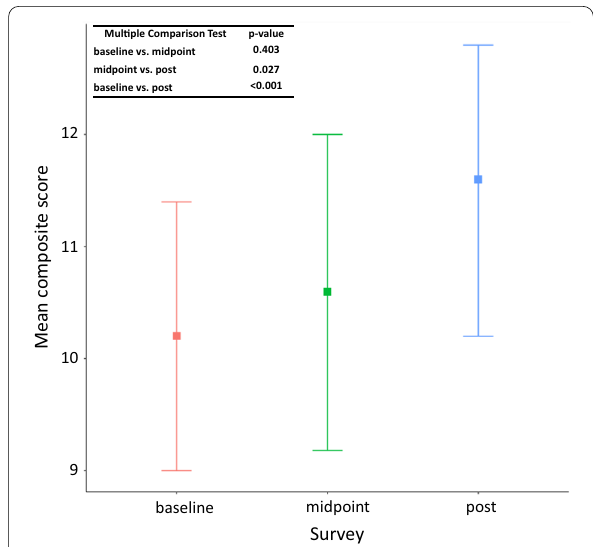
Fig. 3 Repeated measures ANOVA and Tukey multiple comparison tests were conducted to compare participants’ engagement in the skills and practices of science outside the scope of the program based on a composite score of four activities: (1) reading scientific articles; (2) discussing science with friends; (3) discussing science with family; and (4) thinking about science-related problems. Participants exhibited significant increases in engagement of science practices in non-program contexts over two different timepoints (composite score of 4 practices in non-program contexts; estimate: 10.647; SE 0.676; df 32; t 15.759; p < = = =